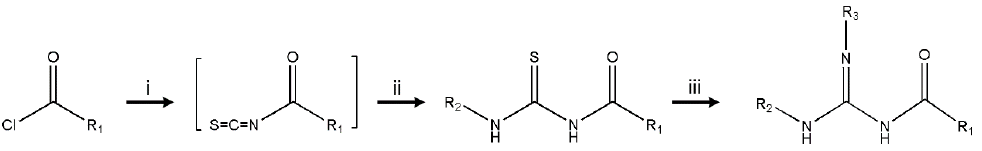
Figure 1. Synthesis of acyl thiourea and guanidine derivatives. Reagents and conditions: ( i ) Acyl chlorides and KSCN in dry acetone, 2 h, reflux. ( ii ) Primary amines in dry acetone. ( iii ) HgCl 2 , substituted aniline and Et 3 N in dry DMF.